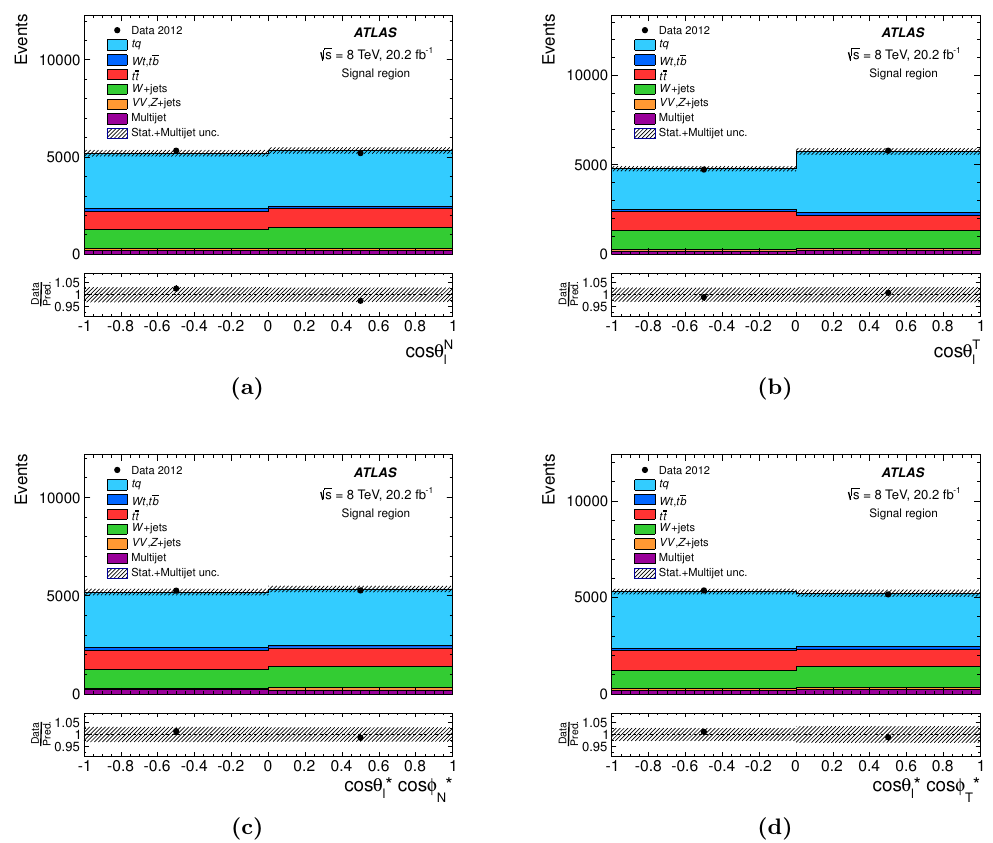
Figure 7. Distributions in the signal region of the angular observables used to measure the various asymmetries: (a) cos (cid:18) N for A N , (b) cos (cid:18) T for A T , (c) cos (cid:18) (cid:3) cos (cid:30) (cid:3) for A N;(cid:30) , and (d) cos (cid:18) (cid:3) cos (cid:30) (cid:3) FB FB N T ‘ ‘ ‘ ‘ FB for A T;(cid:30) . The observed distributions are compared to the predicted signal and background distribu- FB tions, normalised to the results of the maximum-likelihood (cid:12)t. The template t -channel distributions are taken from the baseline Powheg-Box sample. The labels tq and t (cid:22) b refer to the t -channel and s -channel single-top-quark processes, respectively, and V V to diboson production. The uncertainty bands include the statistical post-(cid:12)t uncertainty, the uncertainty due to the limited size of the simulation samples and the uncertainty in the normalisation of the multijet background, added in quadrature. The lower panels show the ratio of data to